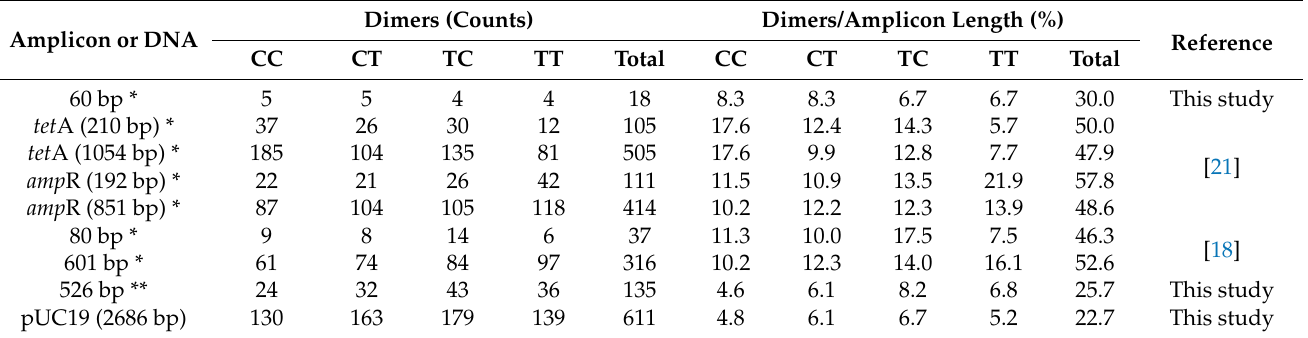
Table 3. Adjacent pyrimidine counts and lengths of target amplicons for qPCR and